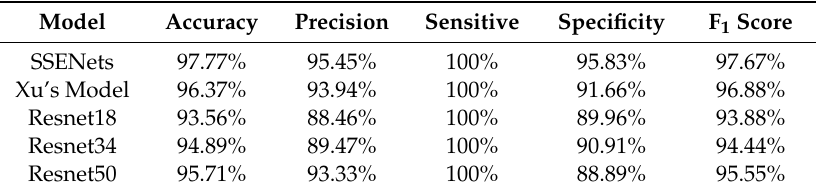
Table 7. Evaluate results of di ff erent models.